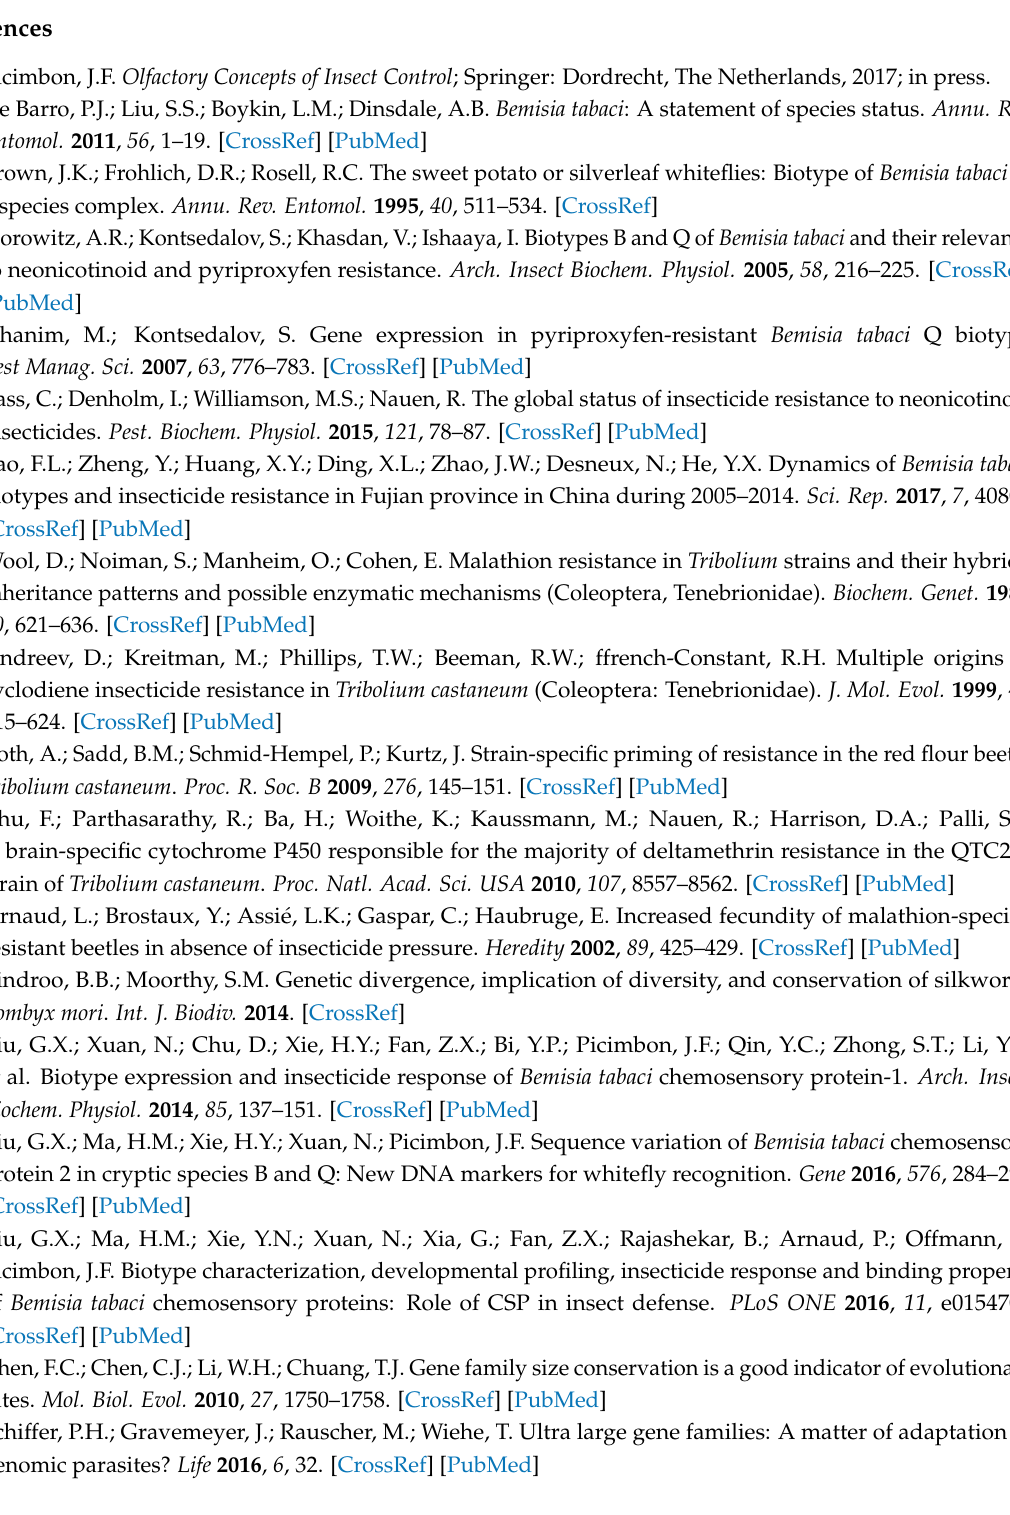
Table S1: Repertoire of 19 CSP sequences identified by in silico analysis of the beetle genome database (BeetleBase, http://www.hgsc.bcm.tmc.edu). * Length (in bps) corresponds to the coding region of the gene from start (ATG) to stop codon